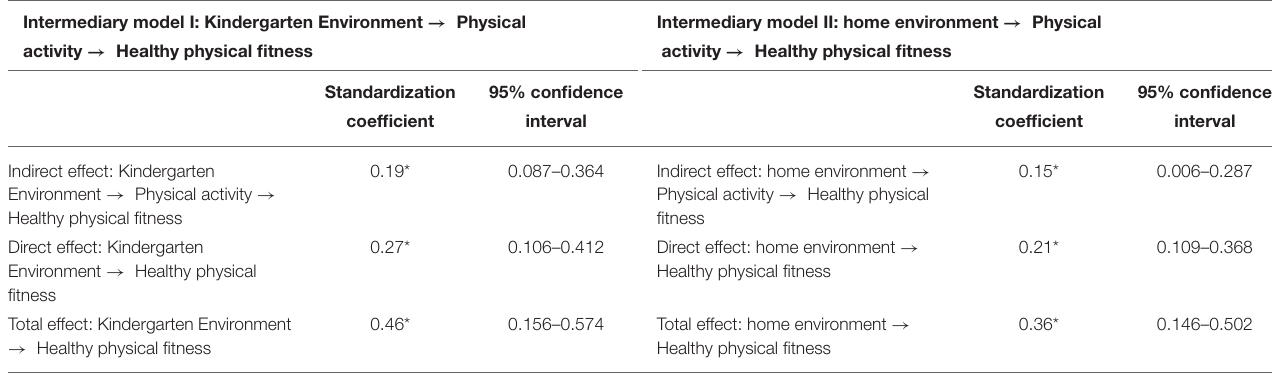
TABLE 4 | Analysis of the mediating effect of physical activity on the relationship between environmental factors and health and physical fitness. Intermediary model I: Kindergarten Environment →